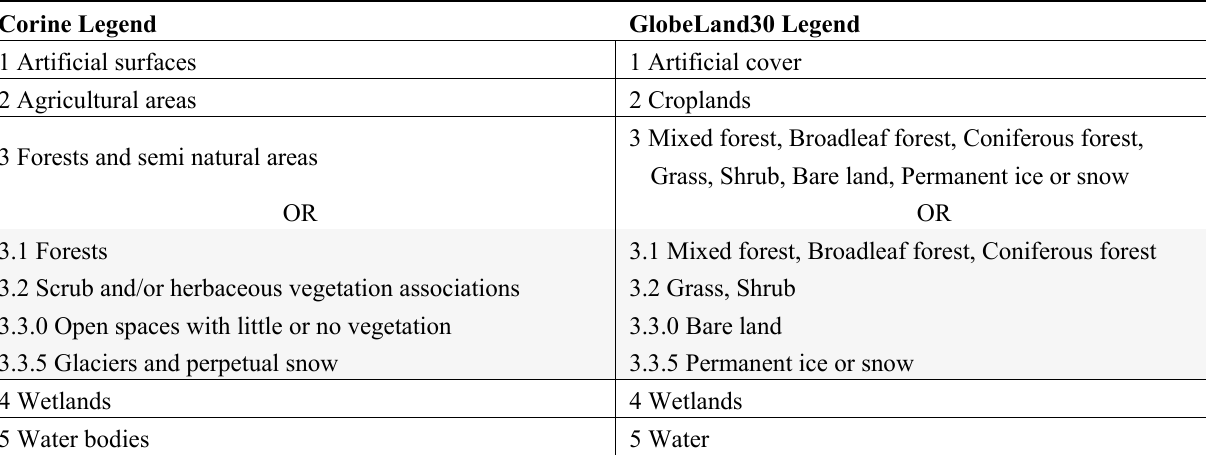
Table 2. First and second reclassification methods: correspondence between GlobeLand30 and Corine